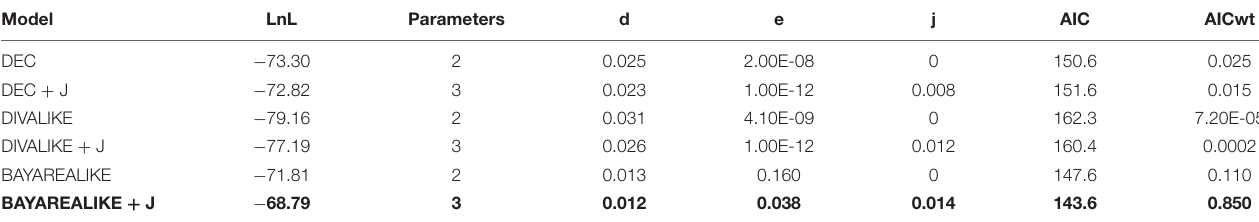
TABLE 2 | Results of the six biogeographic models implemented by BioGeoBEARS on the ancestral range estimation of Sciurini in a Neotropical scale.